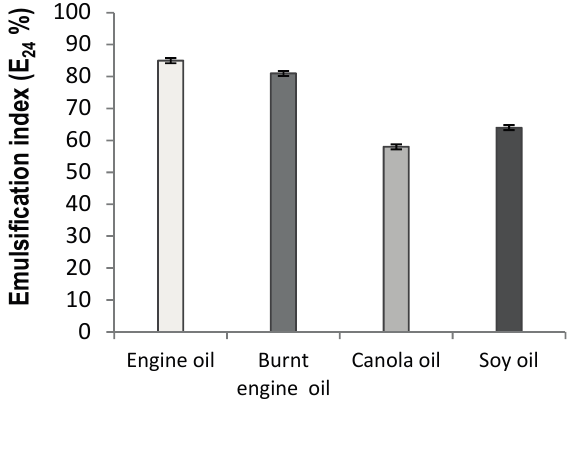
Figure 3. Emulsifier Index (E ) of the biosurfactant produced by Cunninghamella echinulata 24 using corn steep liquor (CSL) and soybean oil waste (SOW) tested with engine oil, burnt engine oil, canola and soy